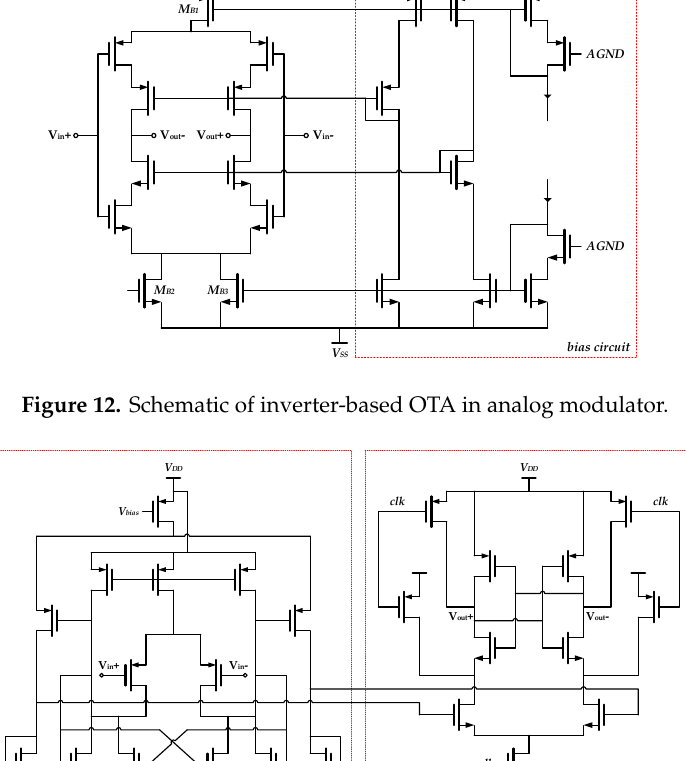
Figure 11. PSD comparison of ΣΔ and zoom modulator.